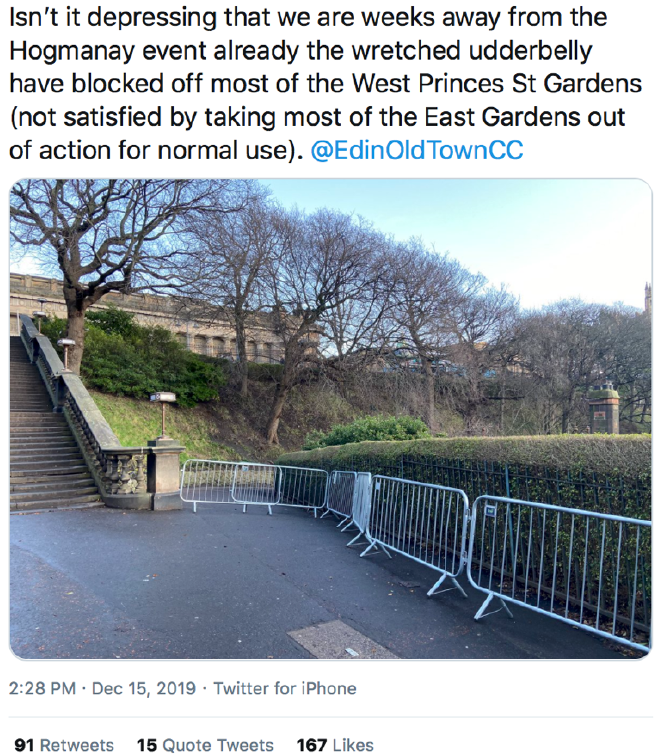
Figure 3. Building the Edinburgh Christmas Markets. Source: Holledge (2019).